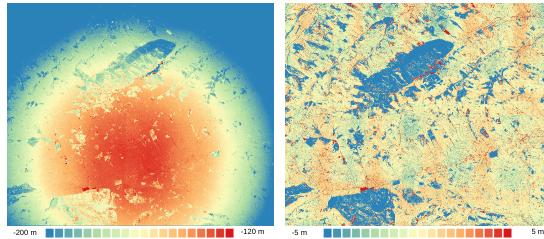
Figure 9. Fabas 1971. Difference between the reference DSM and the archival DSM calculated from coarse georeferencing (left) and from refined georeferencing (right),